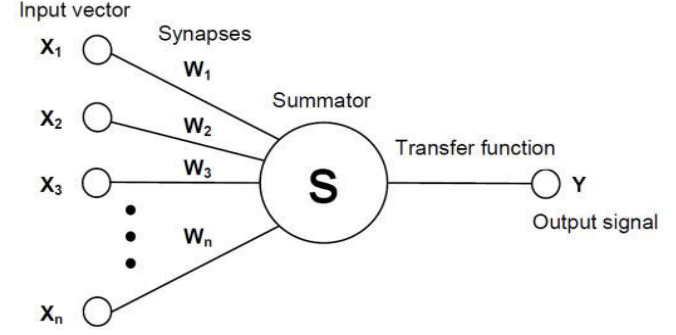
Figure 1. A scheme of an elementary processor of an artificial neuron.